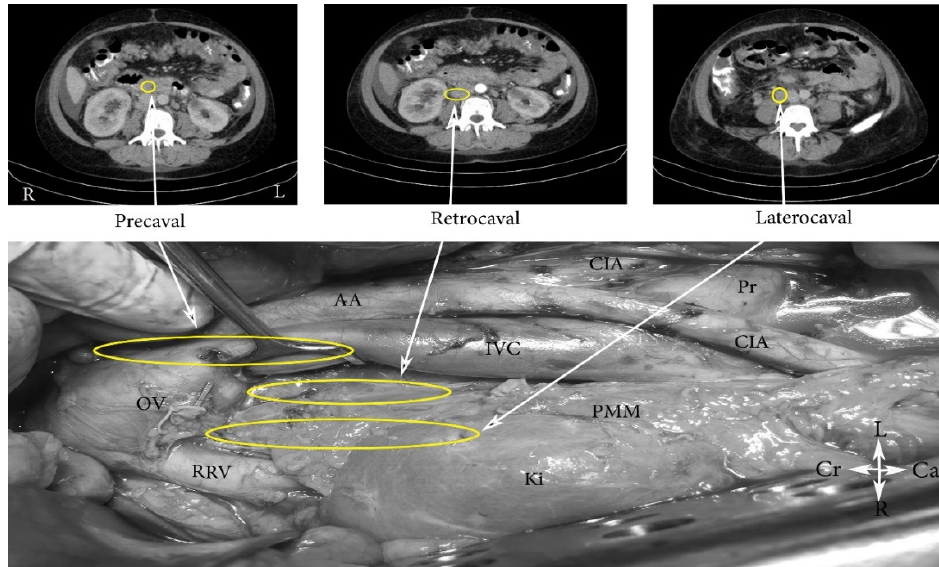
Figure 3. Right lumbar lymph nodes (open surgery). CIA—common iliac artery, IVC—inferior vena cava, AA—abdominal aorta, PMM—psoas major muscle, RRV—right renal vein; Pr—promontorium; OV—ligated right ovarian vein at its insertion to the IVC; IMA—inferior mesen- teric artery, Ki—kidney, Cr—cranial, Ca—caudal, L—left, R—right.